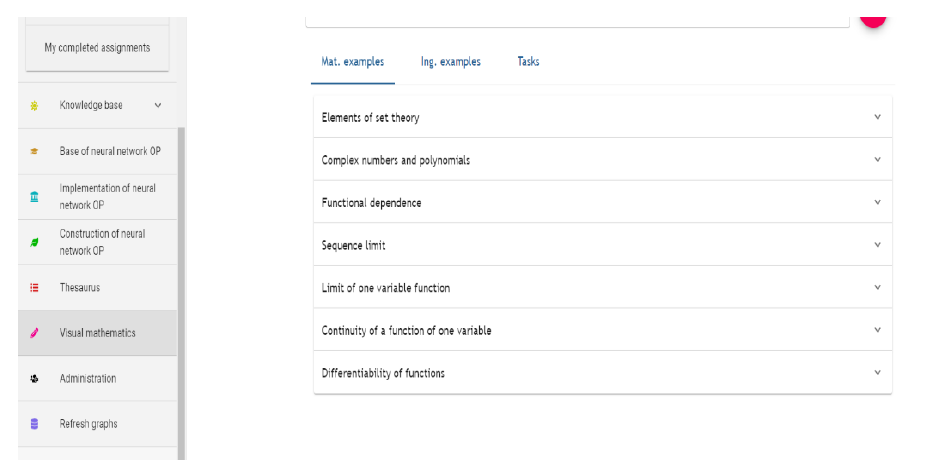
Fig. 1. Window of the «Visual mathematics» subsystem in the Nomotex DLS. Course «Mathematical analysis», Mathematical examples.